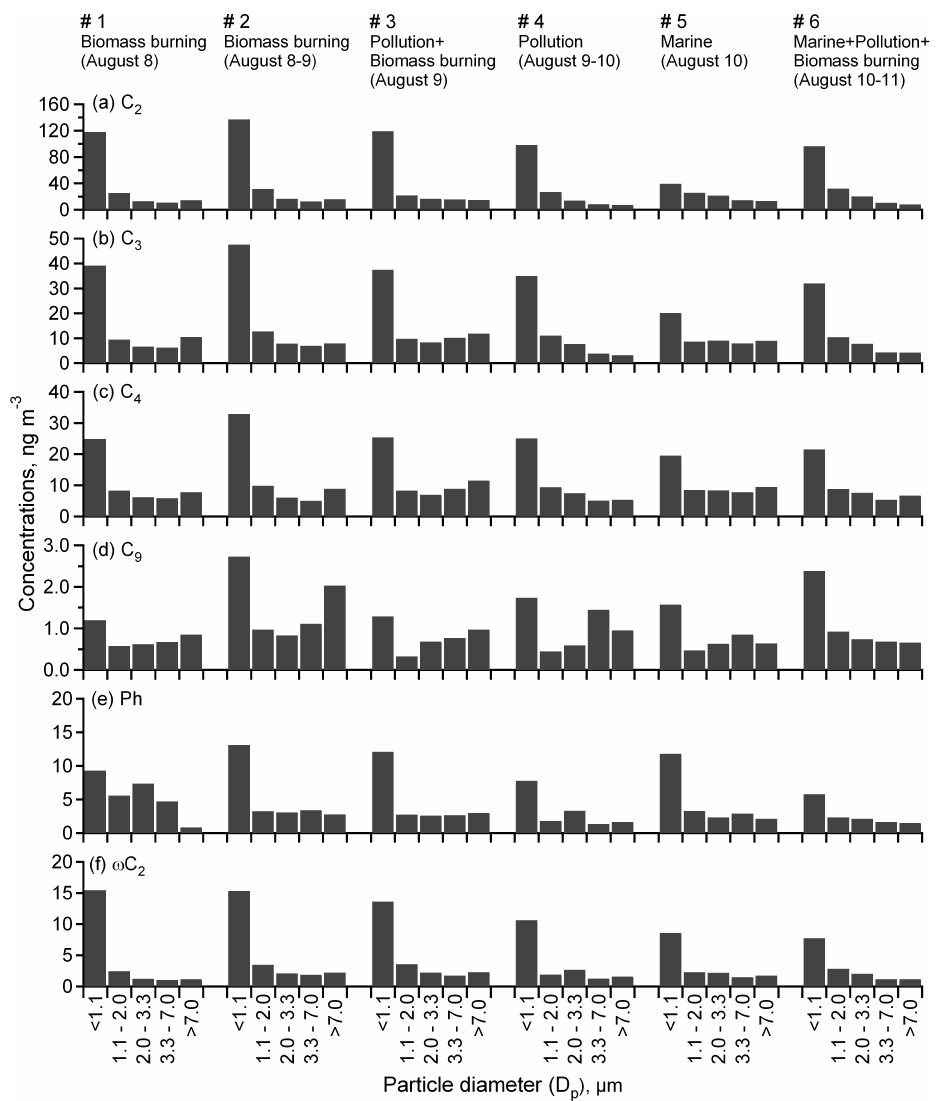
Fig. 5. Size distributions of major diacids and ketoacid in the Sapporo aerosols collected in summer